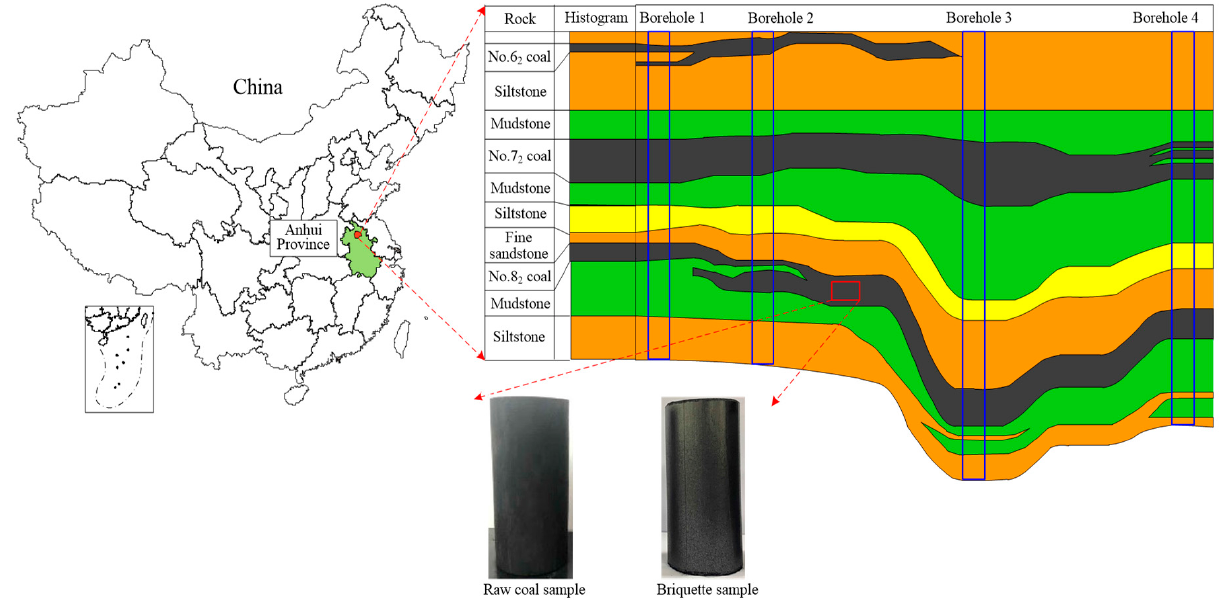
Figure 1. Diagram of the sampling site.